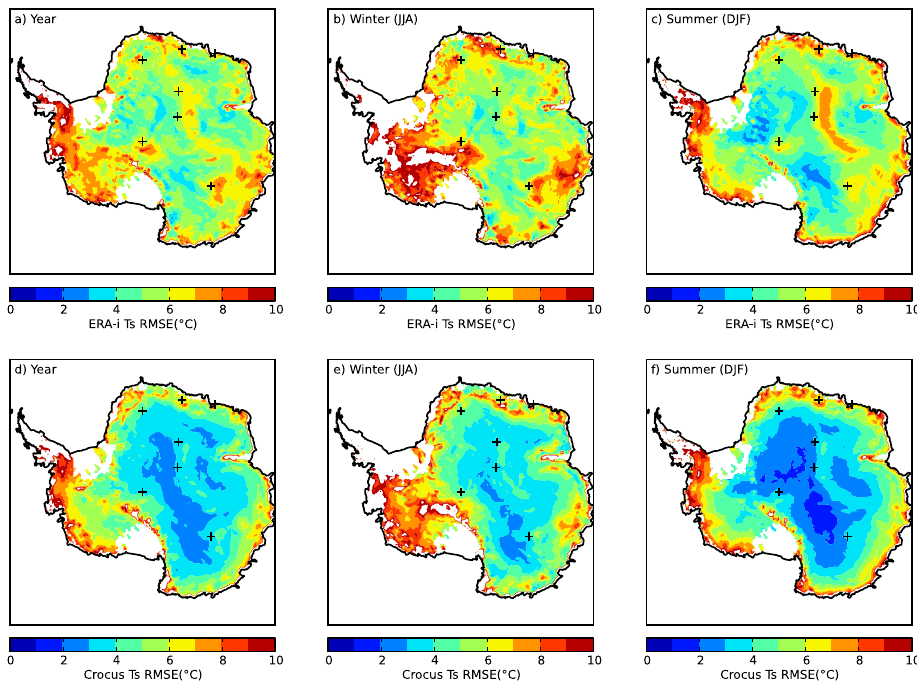
Figure 4. (a) 2000–2011 averaged ERA-i T s RMSE, (b) ERA-i T s RMSE in winter (JJA) and (c) ERA-i T s RMSE in summer (DJF), with respect to MODIS T s . (d) 2000–2011 averaged Crocus T s RMSE, (e) Crocus T s RMSE in winter (JJA) and (f) Crocus T s RMSE in summer (DJF), with respect to MODIS T s